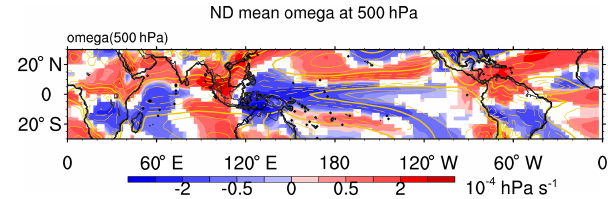
Figure 7. The difference of the ND mean vertical velocity at 500hPa between LGME and piControl (in shading) and the cor- responding climatology derived from piControl (yellow contours). The thick black lines denote the coastal lines in LGME provided by CMIP5–PMIP3, and the thin black lines denote the coastal lines in piControl. Only those areas where the signal-to-noise ratio exceeds 1 are plotted in the difference pattern.